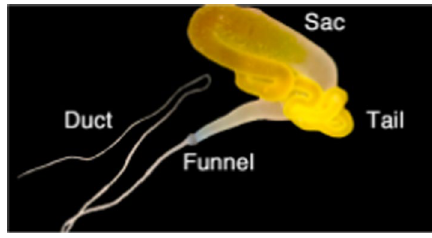
Fig. 2 Macroscopic aspect of a major ampullate gland with Duct, Funnel, Sac and Tail identified (Adapted from